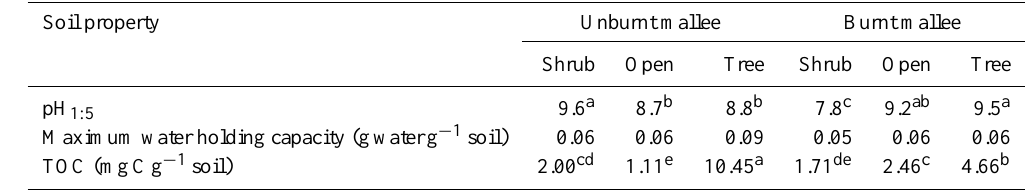
Table 1. Properties of unburnt and burnt mallee soils under shrubs and trees or in open areas (mean, n = 4 for pH and TOC values, n = 2 for water capacity data). For pH and TOC, different letters indicate significant differences for the burning × patch interaction at p <0.05. Soil property Unburnt mallee Burnt mallee